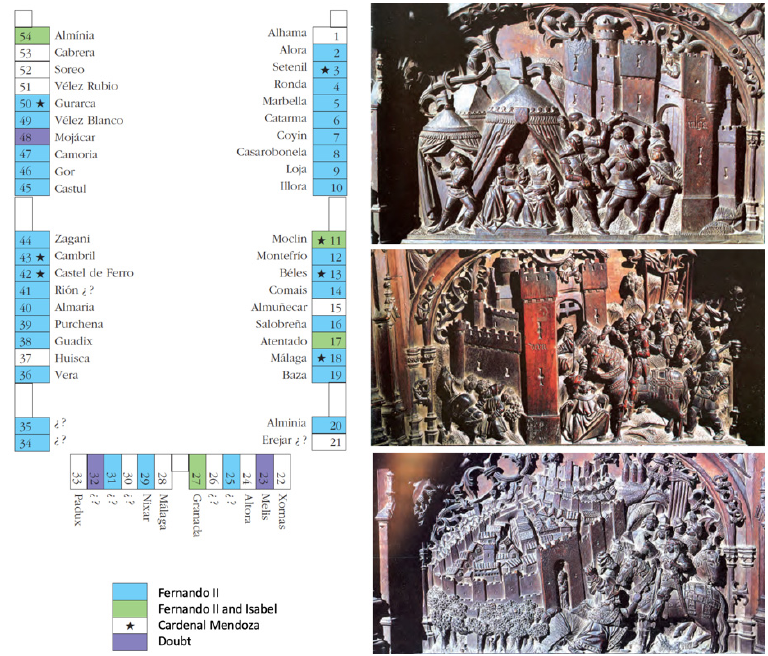
Figure 3. Diagram of the sillería with its protagonists. 1489–1495. Detail of the stalls: 17. Attempt against the Monarchs in Malaga; 36. Surrender of Vera; 27. Handing over the keys of Granada. Published by